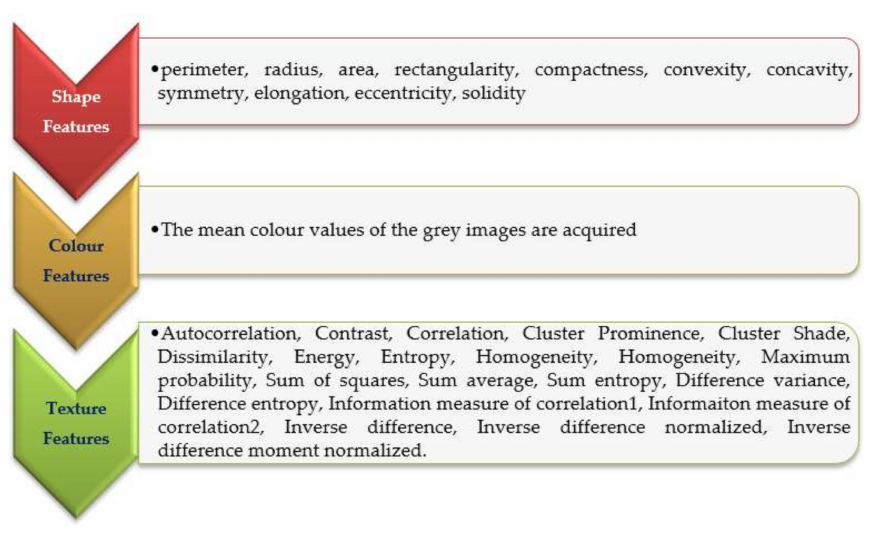
Figure 4. Extracted